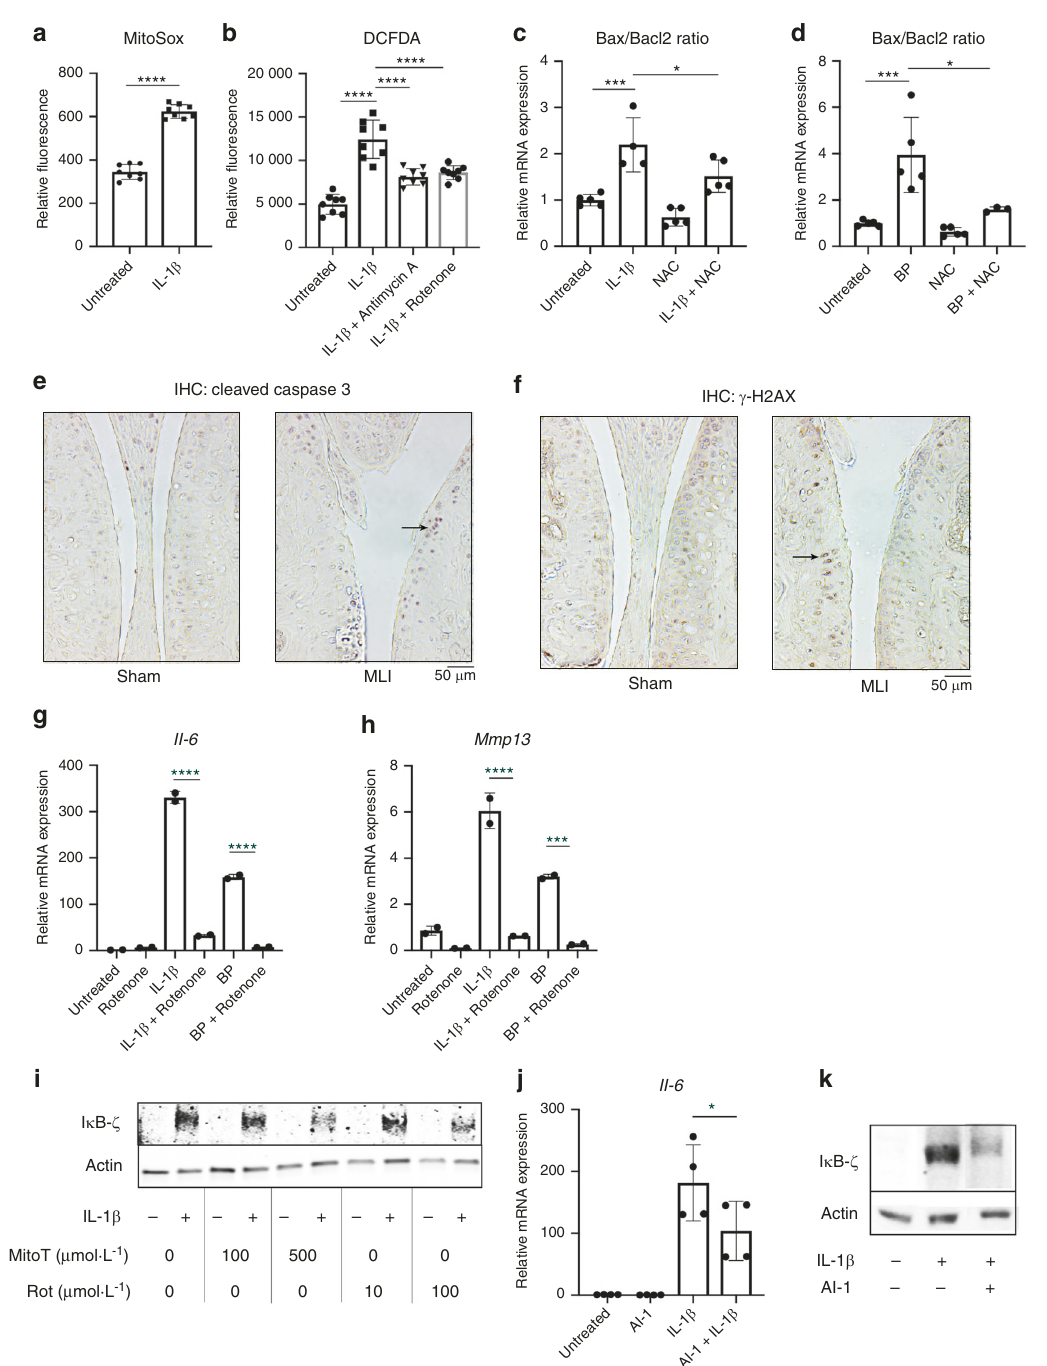
Fig. 7 In fl ammatory mediators promote apoptosis via mitrochondrial oxidative stress. a Mitochondrial superoxide production was measured by MitoSox fl uorescence under similar conditions (**** P < 0.000 1). Bars are mean ± S. for n = 8 replicates from representative experiment. b Chondrocytes treated with IL-1 β ± antimycin A (10 μ mol·L − 1 ) or rotenone (100 μ mol·L − 1 ) for 24 h. ROS levels in the cell were measured by DCFDA fl uorescence (**** P < 0.000 1). Bars represent mean ± SD for n = 8 replicates from representative experiments. c , d Chondrocytes treated with IL-1 β or BP ± NAC (3 mmol·L − 1 ) for 24 h. Bax and Bcl2 gene expression normalized to actin expression. Bax and Bcl2 ratios were then determined, normalizing to untreated cells (A: Untreated vs IL-1 β *** P = 0.000 5, IL-1 β vs IL-1 β + NAC * P = 0.041 9, B: Untreated vs BP *** P = 0.000 4, BP vs BP + NAC * P = 0.011 8). Bars are mean ± S.E.M from n = 5 independent experiments. e , f MLI surgery was performed on 12-week-old mice. Control sham surgery performed on contralateral knee. Joints were collected, embedded in paraf fi n and sectioned. IHC for cleaved caspase-3 and γ -H2AX was performed, with brown stain indicating positive cells. Representative images are displayed. g, h Chondrocytes were exposed to IL-1 β or BP for 24 h ± rotenone (100 μ mol·L − 1 ). Il6 and Mmp13 gene expression was measured by qPCR (**** P < 0.000 1). Bars are mean ± SD from representative experiment. i Chondrocytes were treated with IL-1 β in the presence or absence of mitoTEMPO or Rotenone doses indicated. Western blotting was performed for I κ B- ζ with actin used as control. Representative immunoblot is displayed. j Chondrocytes were exposed to IL-1 β ± AI-1 (40 μ mol·L − 1 ) for 24 h. Il6 gene expression was measured by qPCR. Bars represent mean ± SD from n = 4 replicates. k Western blot was performed for I κ B- ζ under the same conditions. Representative immunoblot is